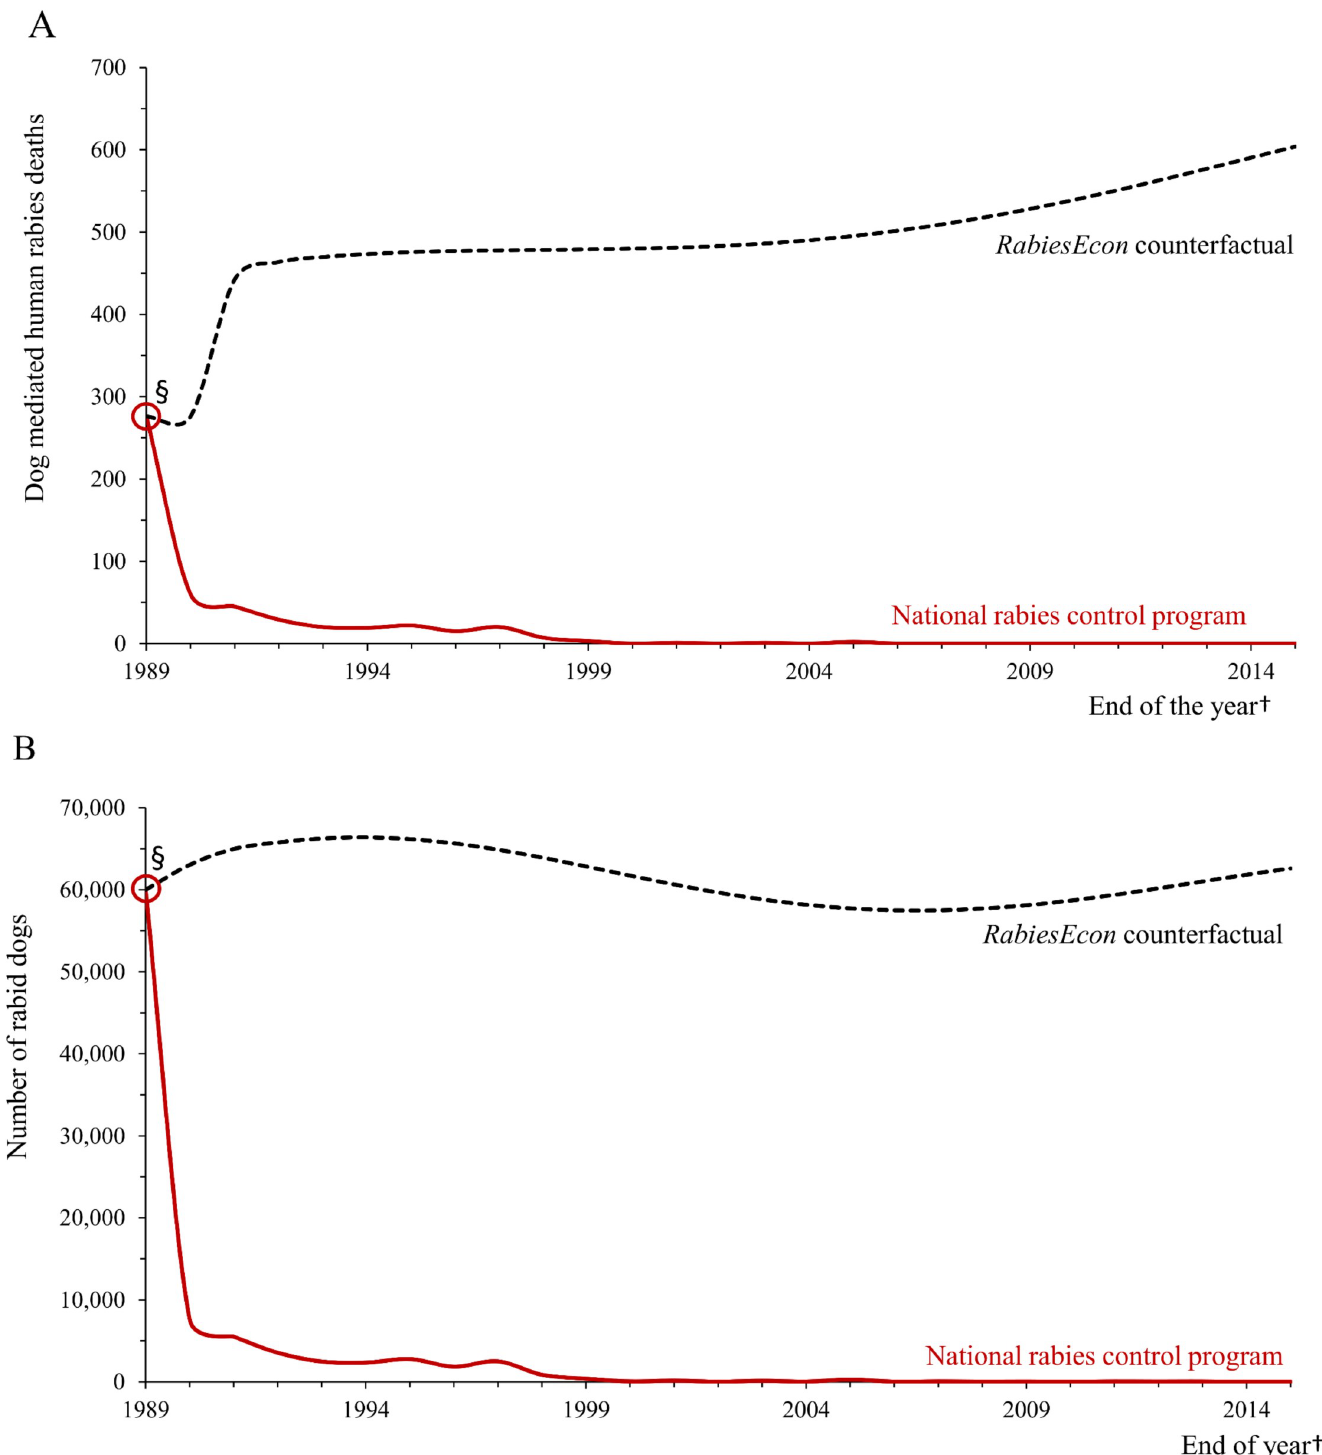
Fig 1. Estimated annual results of the national program of rabies control in Mexico 1990–2015: Dog mediated human rabies deaths with the program in place, as reported by CENAPRECE, and without the program, as estimated by RabiesEcon (A); and estimated number of rabid dogs with the program, as reported by CENAPRECE, and without the program, as estimated by RabiesEcon (counterfactual) (B). § For the counterfactual scenario (no dog vaccination), we estimated the annual number of dog-mediated human deaths and dog rabies cases using the population and rabies transmission parameters reported by CENAPRECE and modeled using RabiesEcon